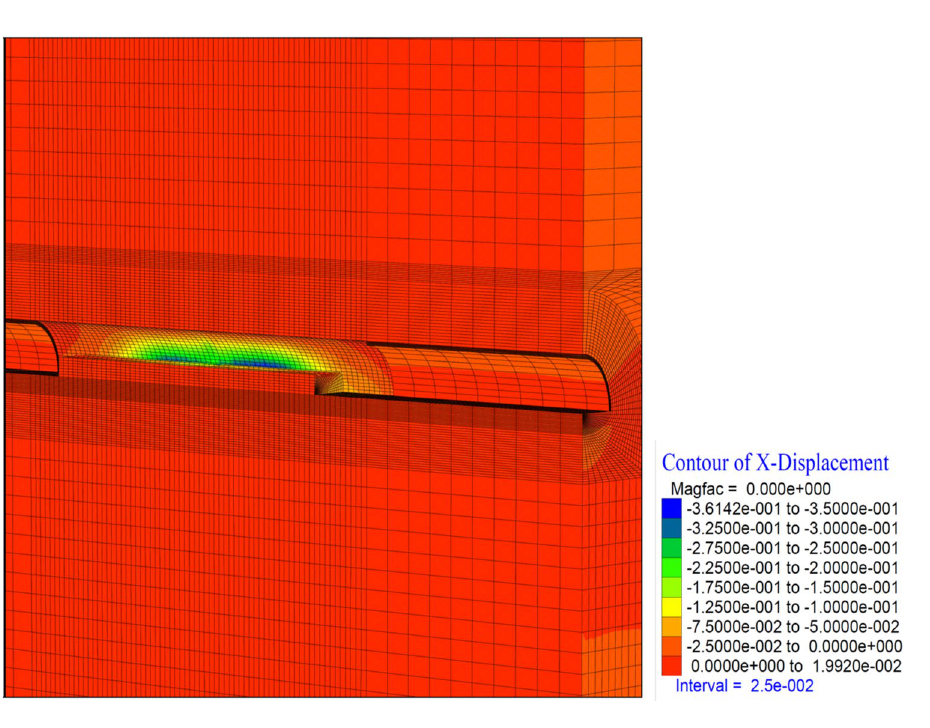
Figure 24. X displacement in stage